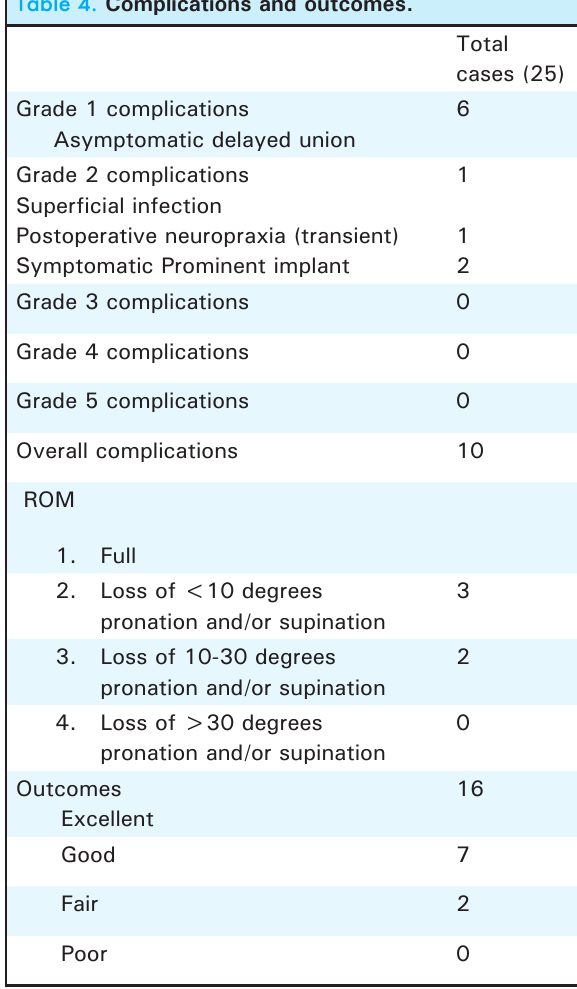
Table 4. complications and